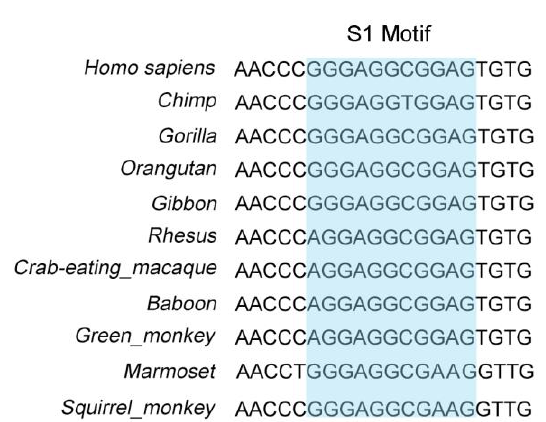
Figure 6. Sequence analysis of the S1 motif in the PCK2 promoter region of different primates.